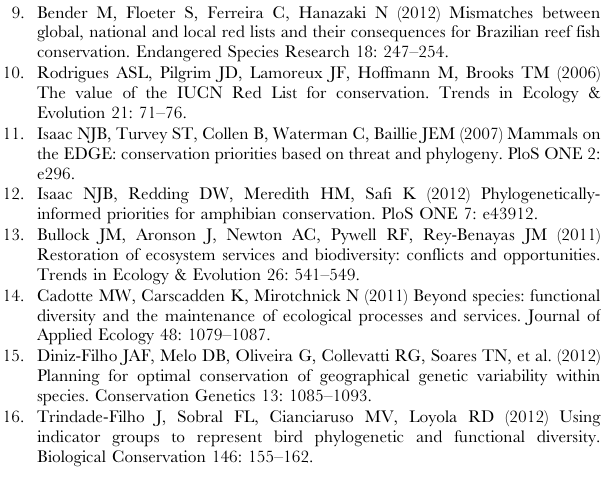
Table S2 Relation between observed functional diver- sity values and the mean of randomized functional diversity values for six Brazilian regions and 48 sites; and the reference for the sites and the status of conservation of these areas, as well as the total number and the number of threatened birds within each Red List category for Brazil, each State and each site. Table S3 Relation between observed phylogenetic di- versity values and the mean of randomized phylogenetic diversity values for six Brazilian regions and 48 sites; and the reference for the sites and the status of conservation of these areas, as well as the total number and the number of threatened birds within each Red List category for Brazil, each State and each